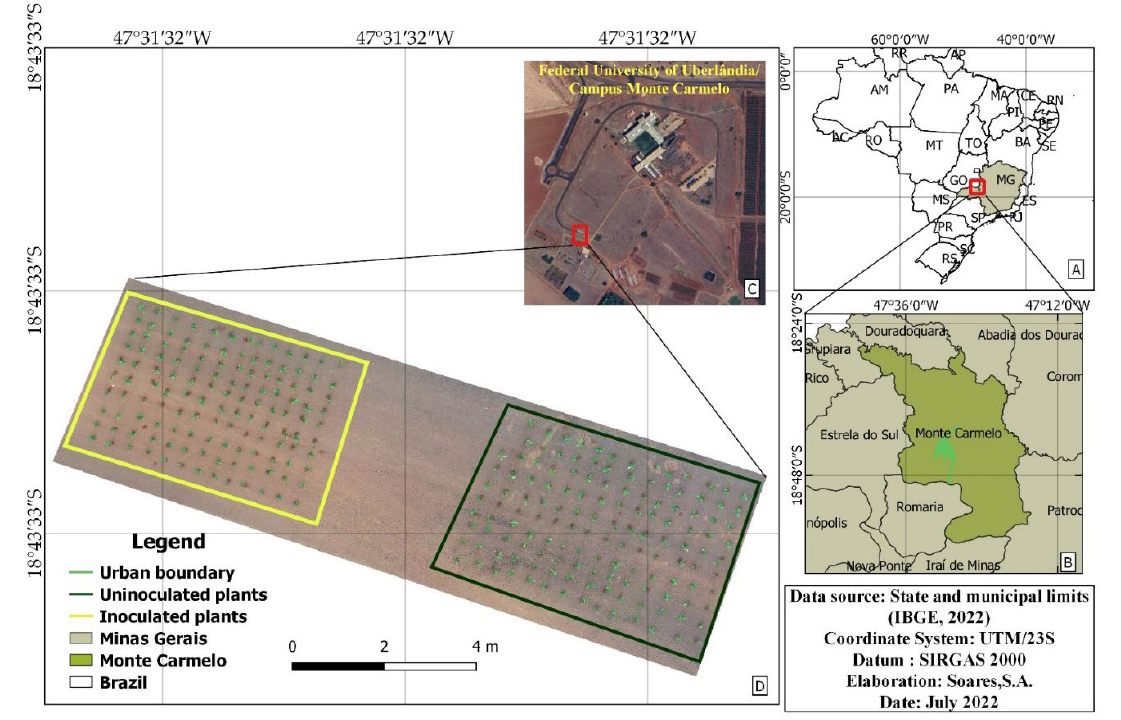
Figure 1. Study area: Location of the experimental area. ( A ) Brazil and the state of Minas Gerais, ( B ) Municipality of Monte Carmelo, ( C ) Aerial view of the Federal University of Uberlândia/Campus Monte Carmelo, ( D ) Experimental area in natural color (RGB) acquired using an unmanned aerial vehicle (UAV).